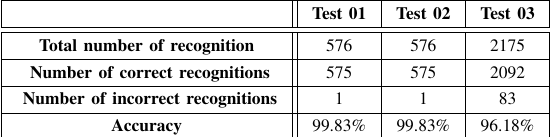
R ECOGNITION PRECISION AND RECALL